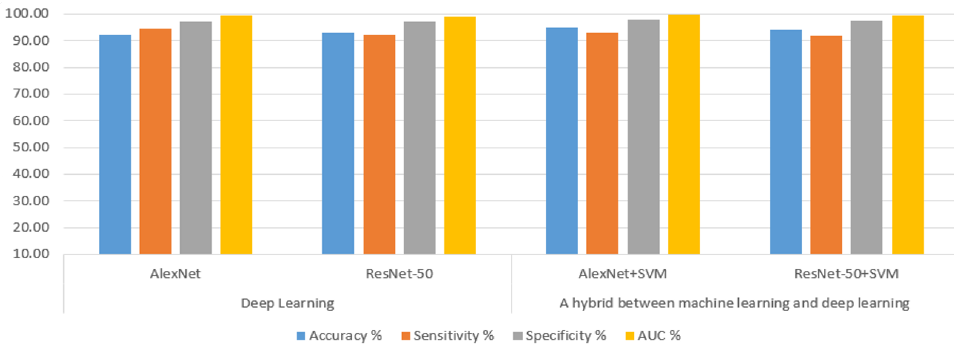
Figure 8. The performances of deep learning and hybrid